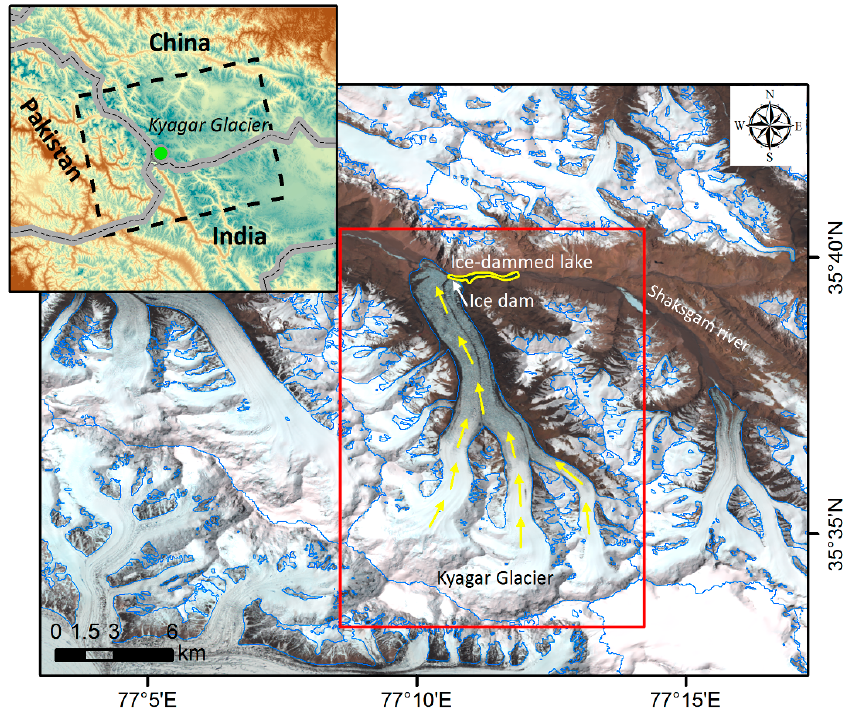
Figure 1. Study area (Shaksgam Valley). Blue curves: outlines of glaciers; yellow curve: outline of the ice-dammed lake; yellow arrows: approximate directions of horizontal glacier flow; dashed rectangle in inset: frame of Sentinel-1A images; red rectangle in the main panel: area shown in Figure 5.